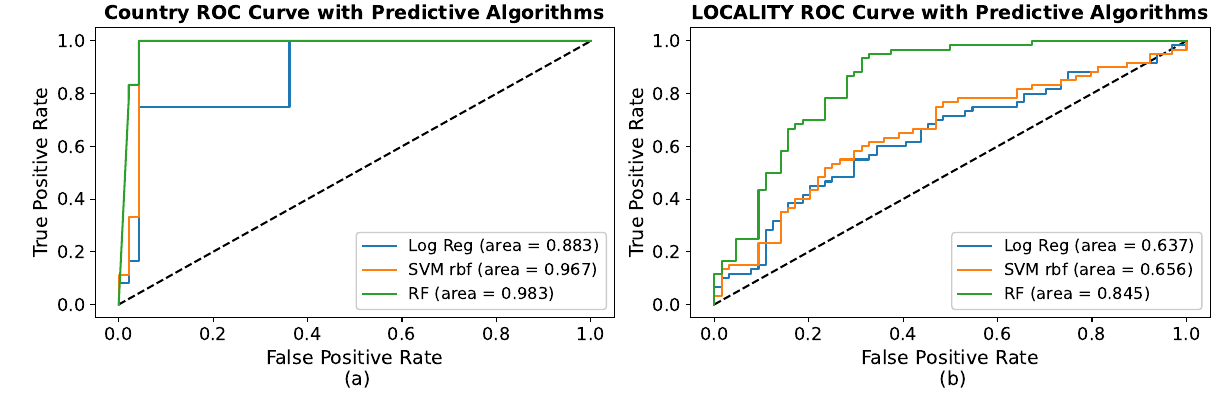
Figure 12. ROC analysis of geographic feature identification: ( a ) country, ( b )